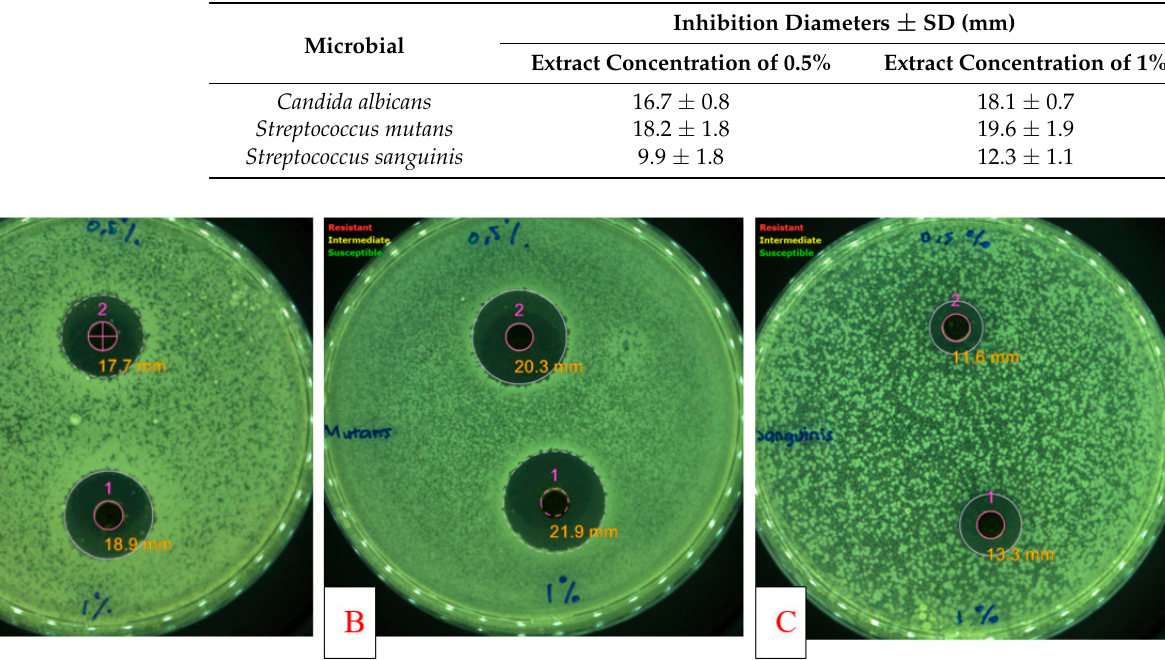
Table 2. Growth inhibition diameters of Candida albicans, Streptococcus mutans, and Streptococcus sanguinis by Piper betle var. nigra isolate piperamide A and B.